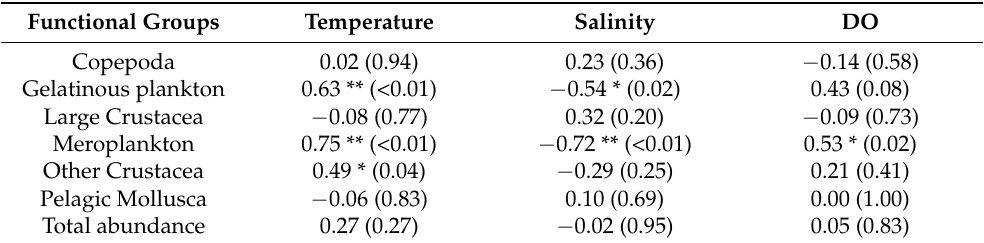
Table 1. Pearson’s correlation of functional groups mean abundance and environmental parameters. The numbers in parentheses are p